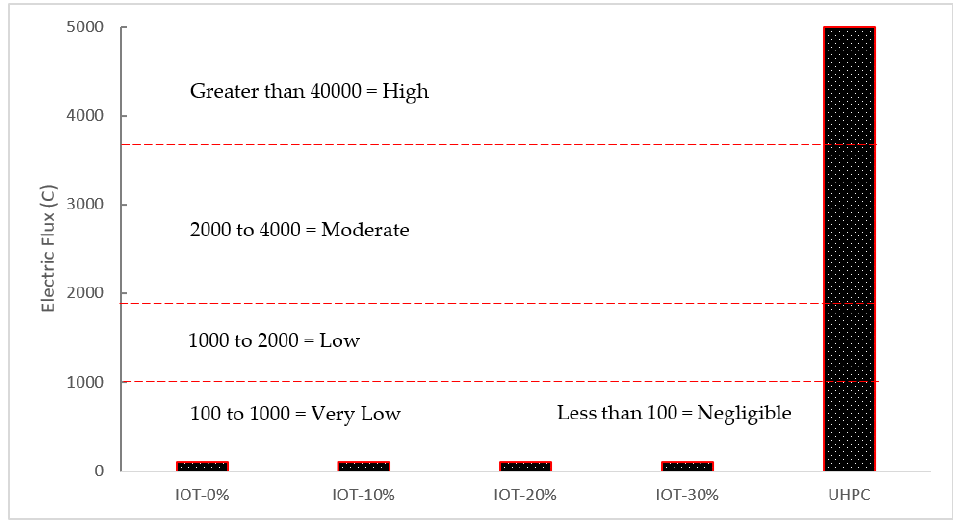
Figure 13. Chloride resistance (data source